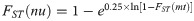
Comparisons of pairwise FST values for nuclear microsatellites with ΦST values from mitochondrial DNA; the line indicates the expectation of FST(nu)=1−e0.25×ln[1−FST(mt)] under isolation as given in [56].(a) S4 Fig from Peacock et al., 2015 [20], reproduced here under the terms of its Creative Commons CC0 license. (b) A recreated version of this graph, generated using our recalculated FST and ΦST values. In (b), M’Clintock Channel, Norwegian Bay, and Viscount Melville Sound were excluded because of inadequate sample sizes for mitochondrial DNA (N ≤ 3) and the Laptev Sea was excluded because this MU was significantly out of Hardy–Weinberg equilibrium. Points for brown bears were not recalculated and are not shown. Coloured points indicate intra-cluster MU pairs (coloured as in Fig 4); grey points indicate inter-cluster MU pairs.